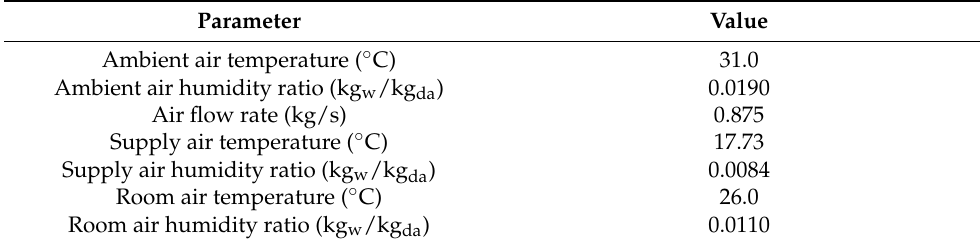
Table 9. Nominal conditions for the exergy efficiency calculation.